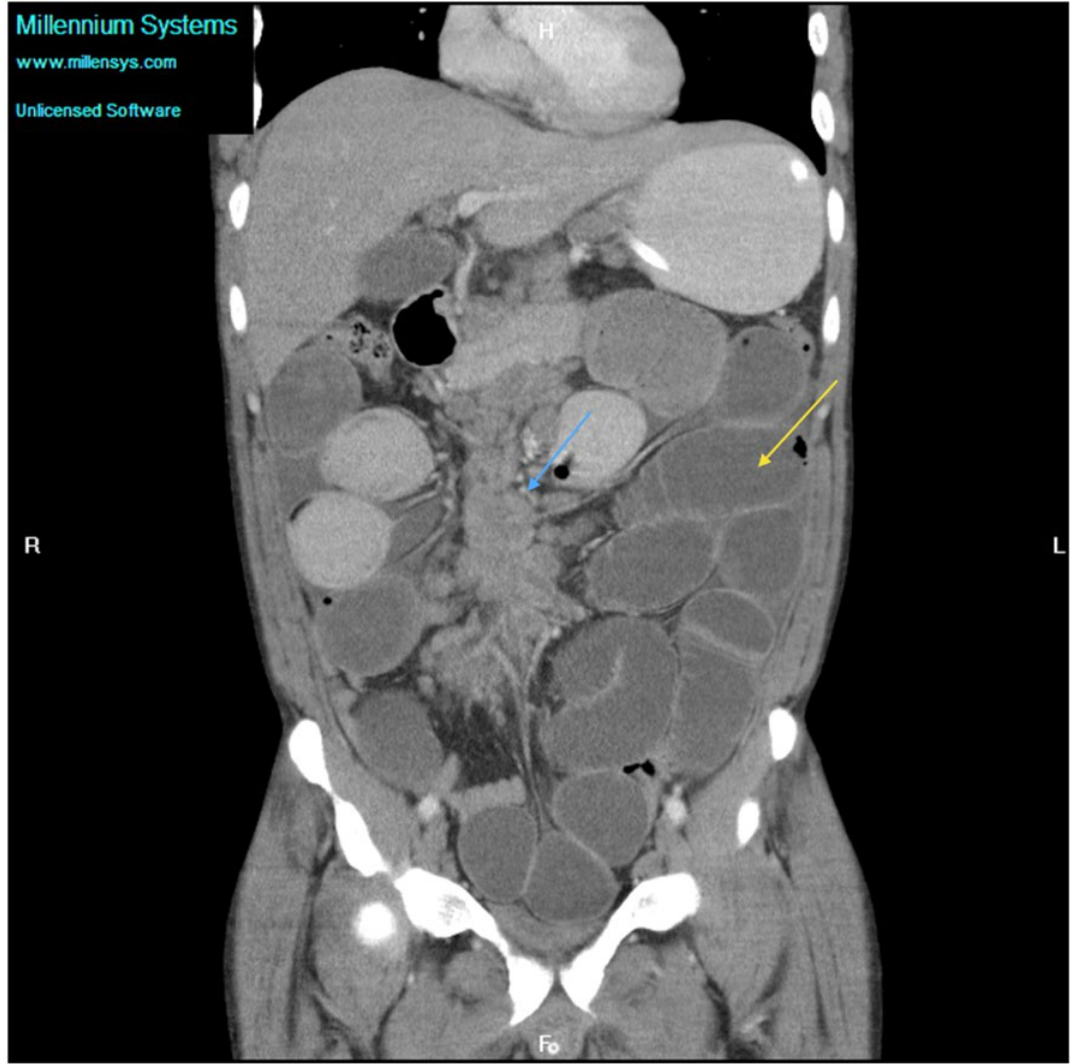
Figure 6c: Coronal CT showing gross small bowel dilatation (yellow arrow) with extensive mesenteric adenopathy (blue arrow) secondary to tuberculosis